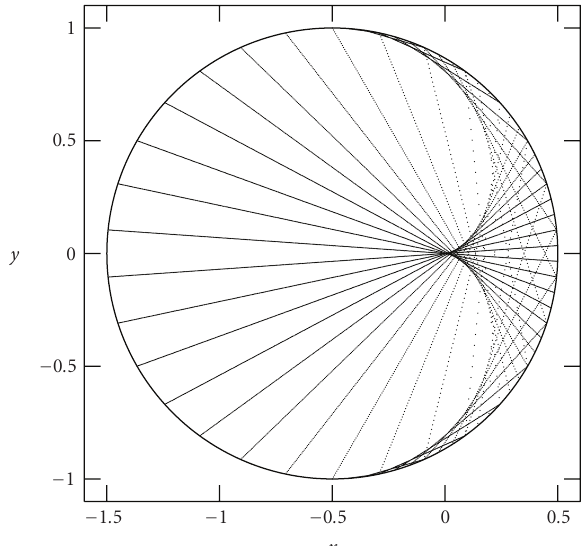
Figure 1: Light rays reflected by a polished metal ring or the inner surface of a reflective co ff ee cup. The caustic is the envelope of the family of